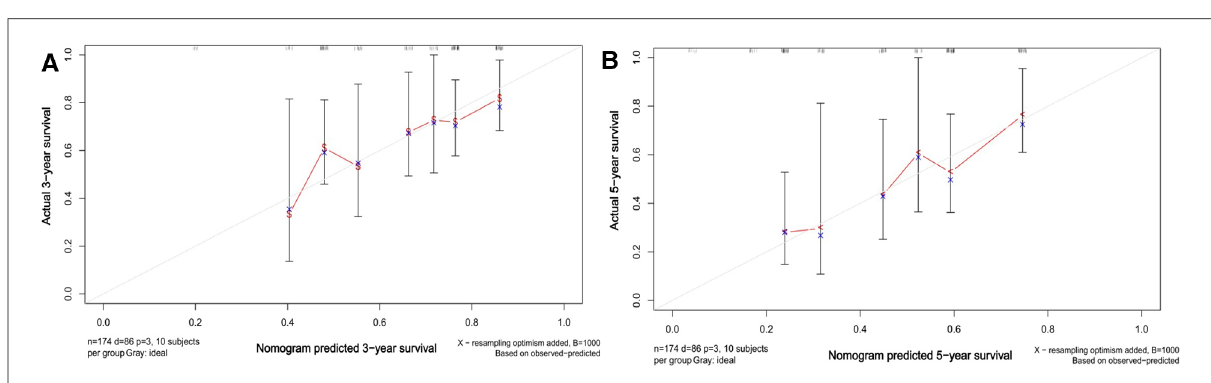
FIGURE 6 Calibration plots of the nomogram of OS predictions for CRLM hepatectomized patients. A and B show the predicted and actual 3- and 5-year survival probabilities for CRLM hepatectomized patients,